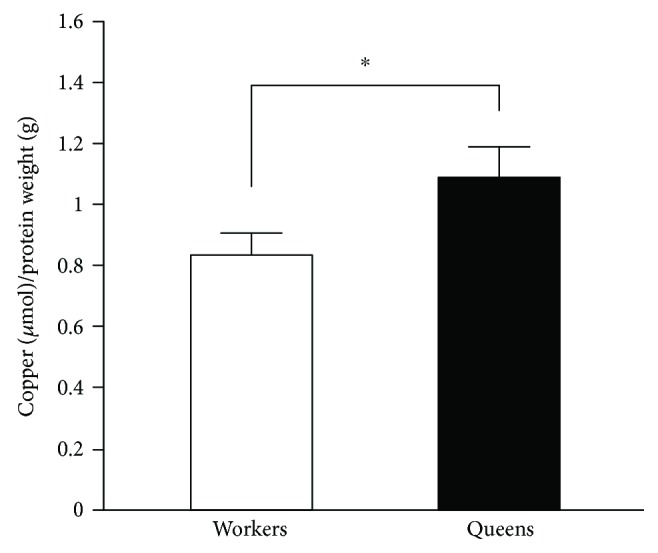
Measurement of copper concentrations in R. speratus queens and workers. Queens (n = 16) had significantly higher concentrations of copper than workers (n = 16; P = 0.038). We used pooled samples, as described in Table
S1, for several replications. White and black bars indicate workers and queens, respectively. Error bars represent SEM. Significance was measured by unpaired t-test (∗
P < 0.05).